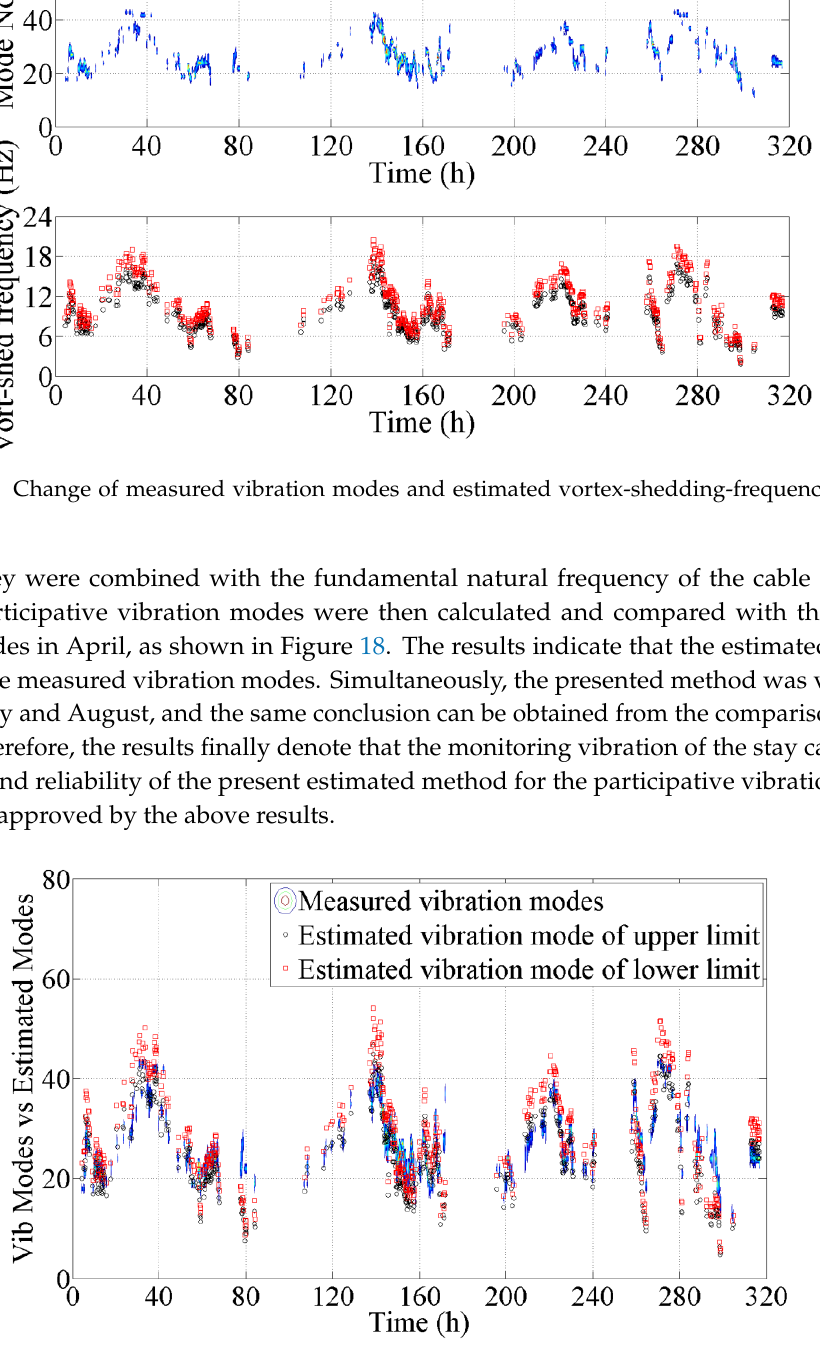
Figure 18. Comparison of measured vibration modes and estimated vibration modes in April.